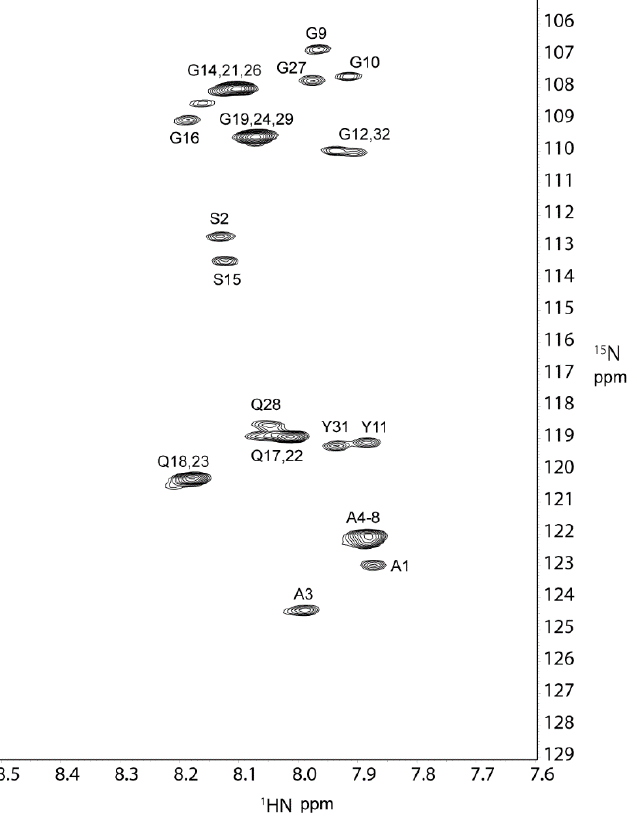
Figure 2. The 2D 1 H- 15 N HSQC spectrum of U-[ 13 C, 15 N] labeled RSP in FA at 298 K, 600 MHz. The 17 backbone cross-peaks are labeled with amino acid and residue number and listed in Table 1.